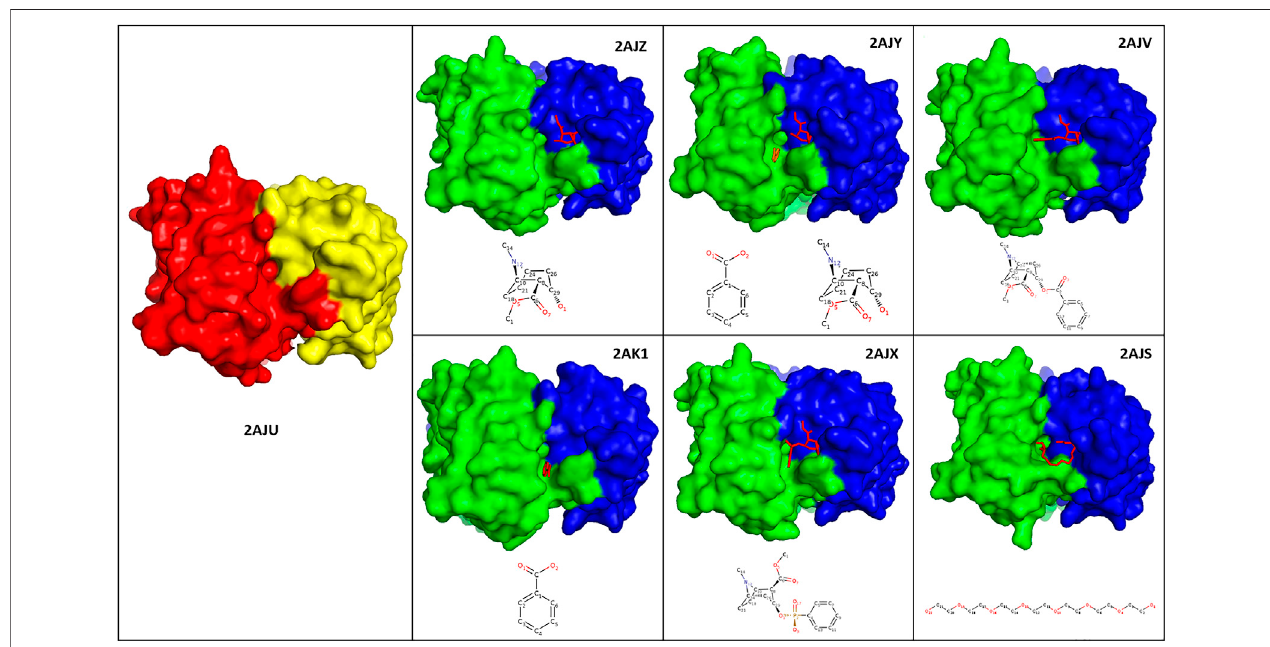
FIGURE 4 | Binding sites of antibody 7A1. Illustration of the crystal structures of antibody 7A1 as free form (2AJU) and six antigen bound states against Ecgonine methyl ester (2AJZ), Ecgonine methyl ester and benzoic acid (2AJY), Cocaine (2AJV), Benzoic acid (2AK1), 3-(hydroxy-phenyl-phosphinoyloxy)-8-methyl-8-aza-bicyclo [3.2.1]octane-2-carboxylic acid methyl ester (2AJX), and PEG330 (2AJS). The heavy and light chains of the antibody-free form of 2AJU were colored as red and yellow, respectively. Whilst green (heavy chains) and blue (light chains) was used to color the antigen bound structures. Chemical structure of each of the antigens was depicted at the bottom of each crystal